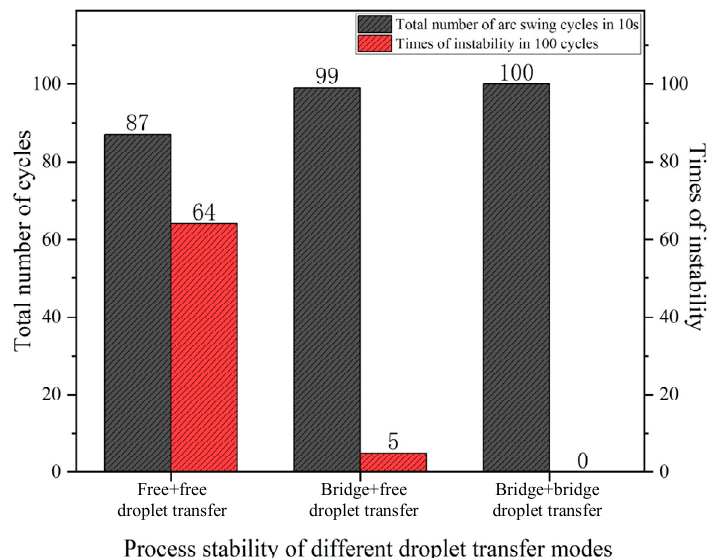
Figure 9. Stability comparison of three droplet transfer modes.